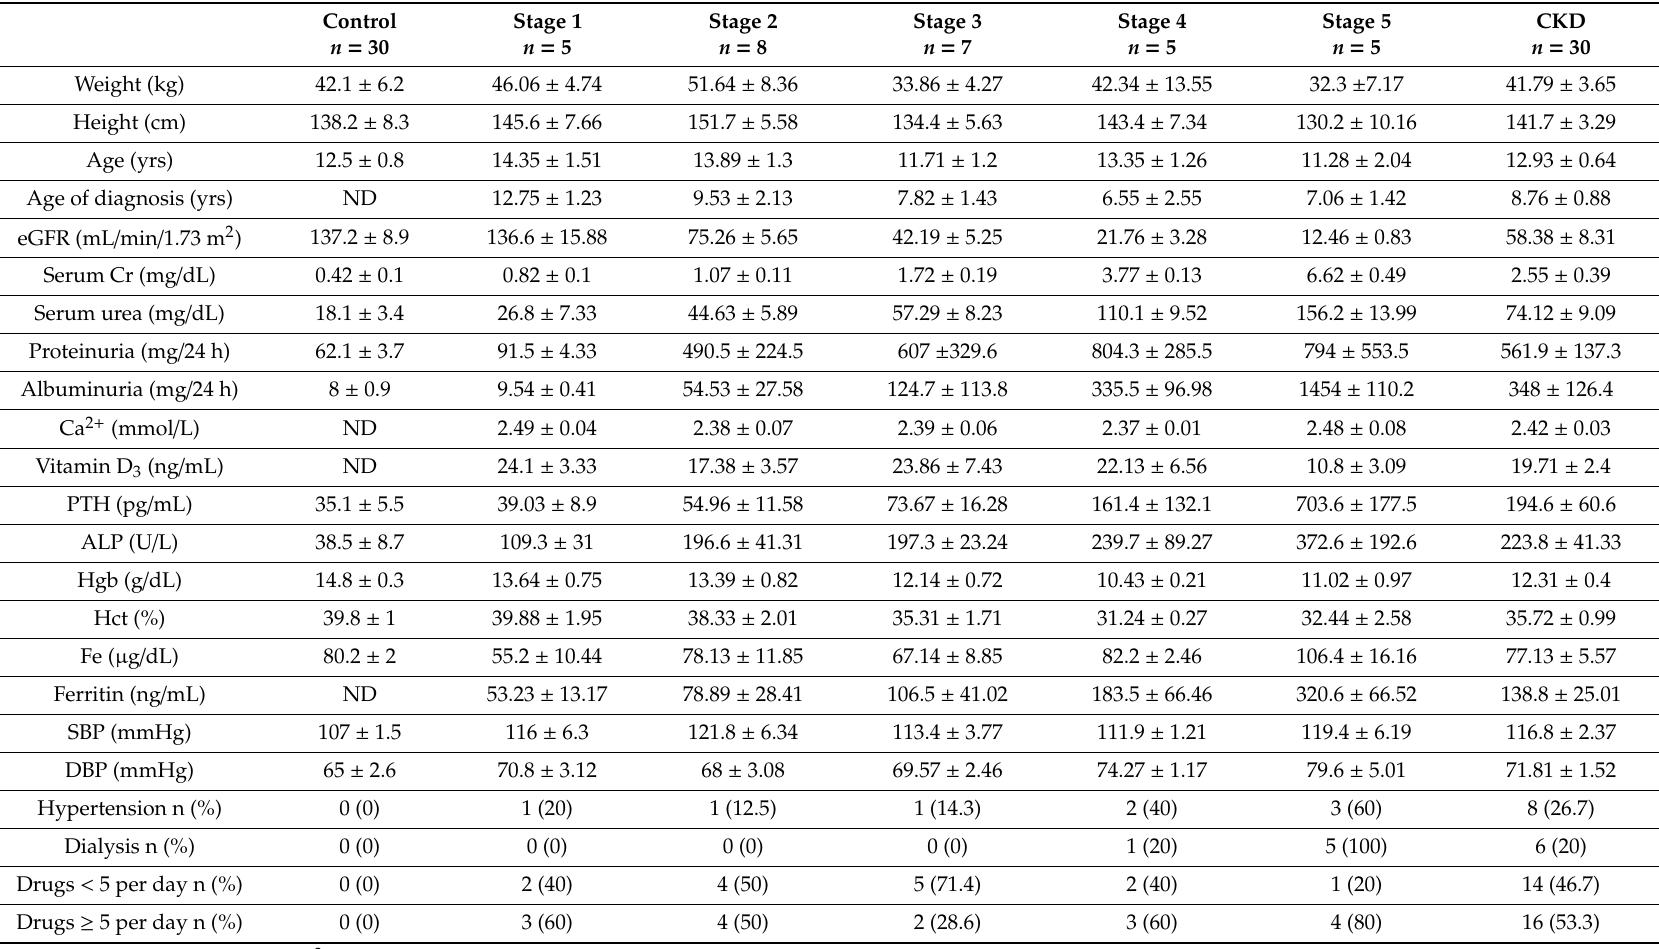
Table 1. Clinical characteristics of children with di ff erent stages of chronic kidney disease (CKD) and healthy